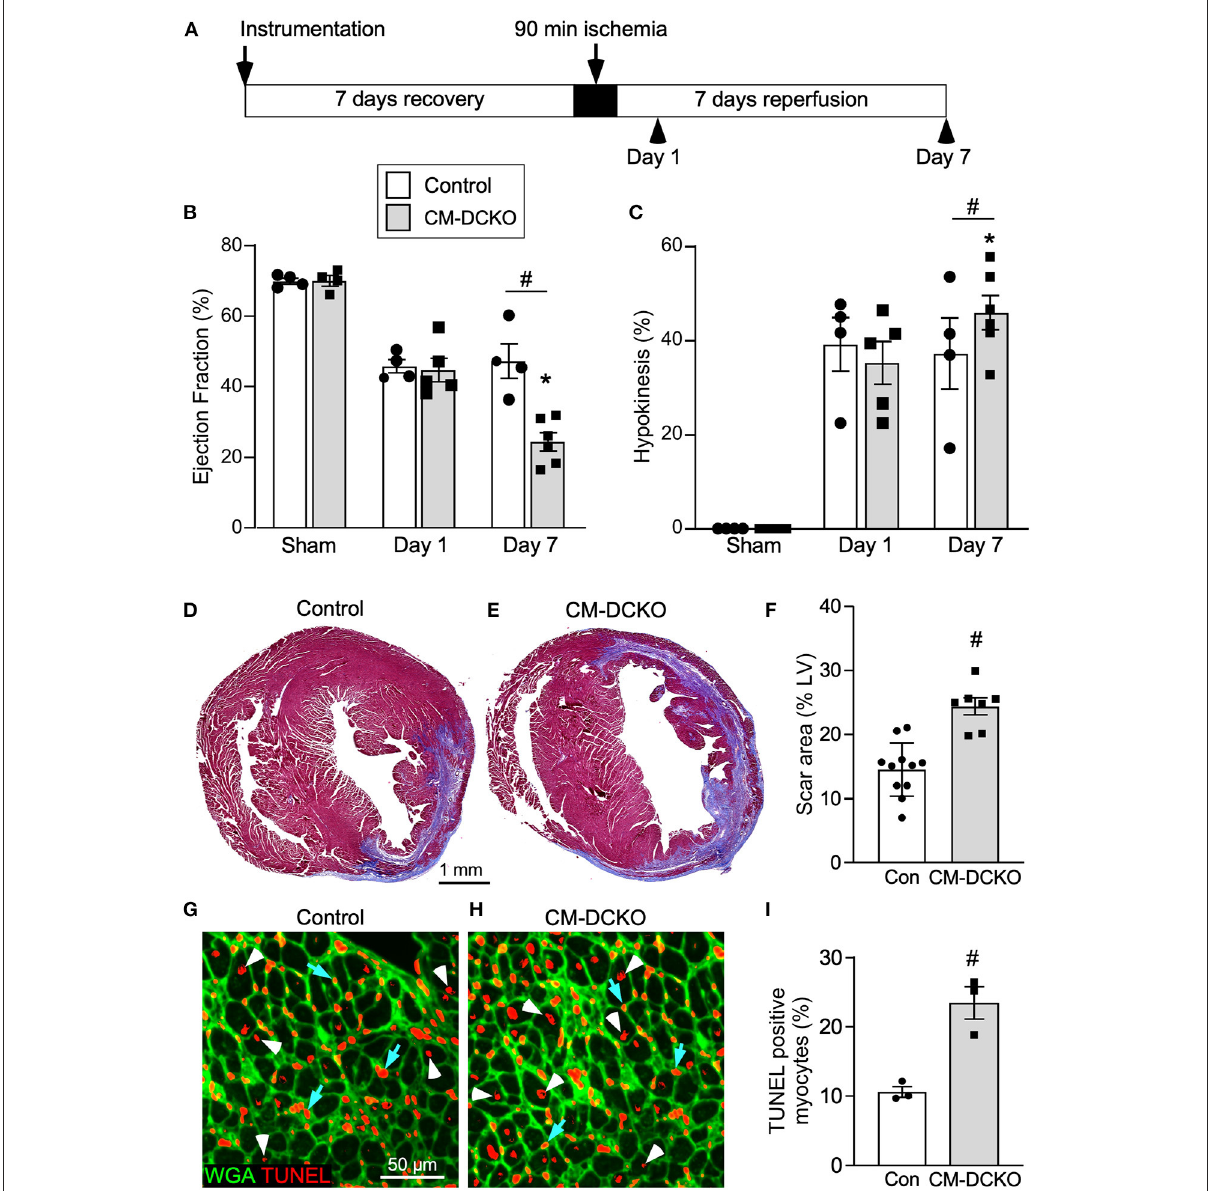
FIGURE2 I/R injury model for mice lacking cardiomyocyte Fgfr1 and Fgfr2 . (A) Schematic showing experimental plan and analysis time points for the acute phase following I/R injury. (B,C) Measurements of cardiac function before (Sham) and 1 day and 7 days after reperfusion. Both Control and CM-DCKO mice show a similarly decreased ejection fraction (B) and increased hypokinetic area (C) 1 day after reperfusion. At 7 days after reperfusion, CM-DCKO mice show a further decrease in ejection fraction and increased hypokinetic area indicating worsened cardiac function. (D–F) Histological analysis of scar area (Masson’s trichrome stain) 7 days after reperfusion. Relative to Control (D,F) , CM-DCKO hearts (E,F) show a significantly increased scar area. n = 7–11; Scale bar = 1mm. (G–I) Analysis of myocyte cell death in the periinfarct region 1 day after reperfusion showing increased TUNEL positive, WGA (CF ® 640R, green) positive myocytes in CM-DCKO hearts (H,I) compared to Control hearts (G,I) . TUNEL positive nuclei (red), WGA (green). Scale bar = 50 µ m; # p < 0.05 vs. control; * p < 0.05 vs. sham.